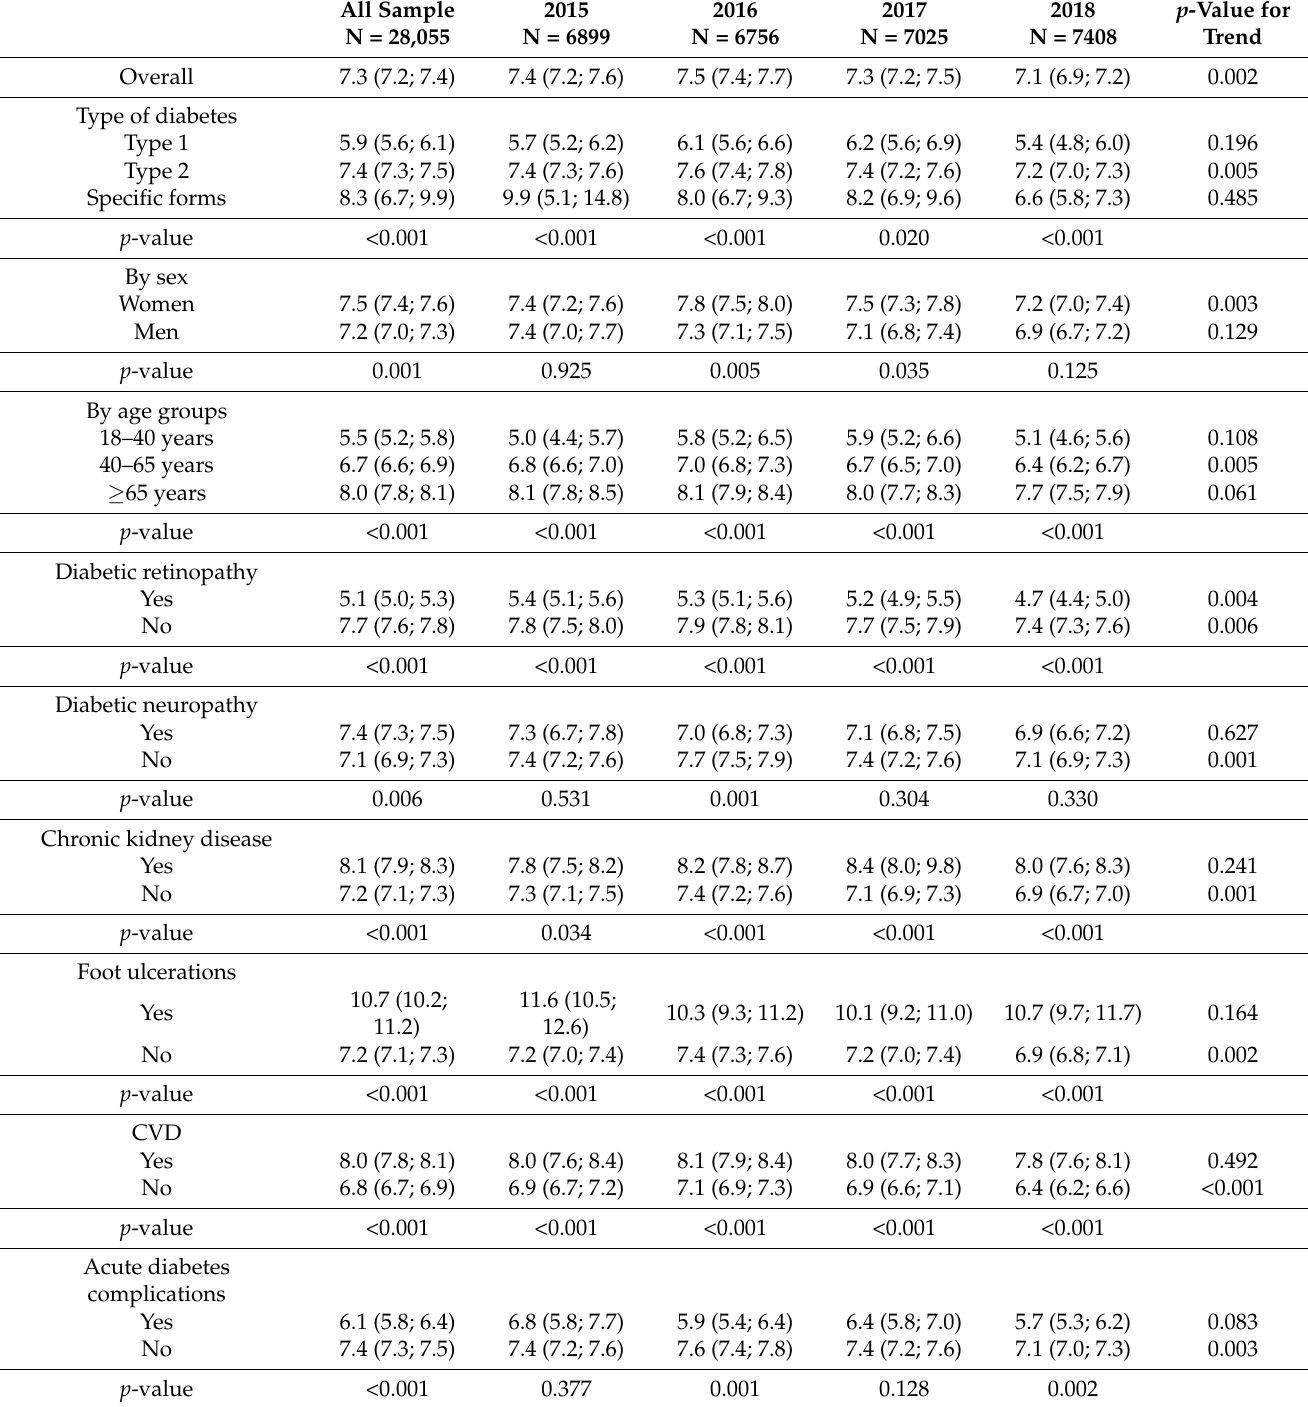
Table 2. Assessment of average length of stay * per episode of